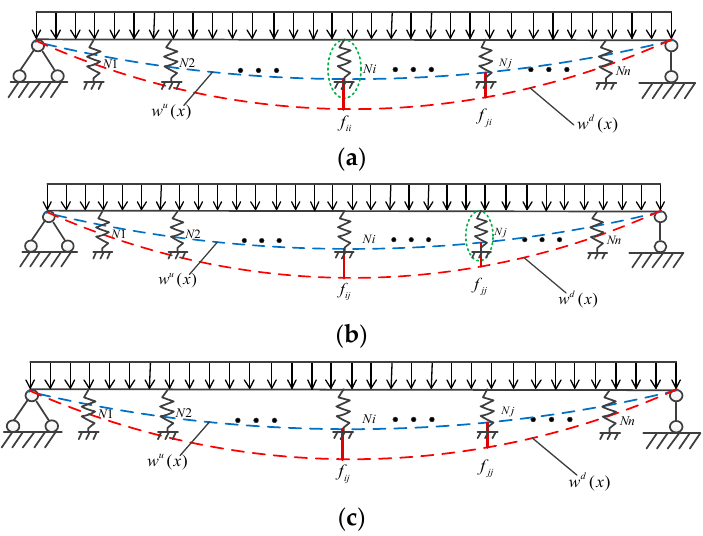
Figure 1. Mechanical model: ( a ) the hanger Ni is completely damaged; ( b ) the hanger Nj is completely damaged; ( c ) unknown damaged state of the hanger.